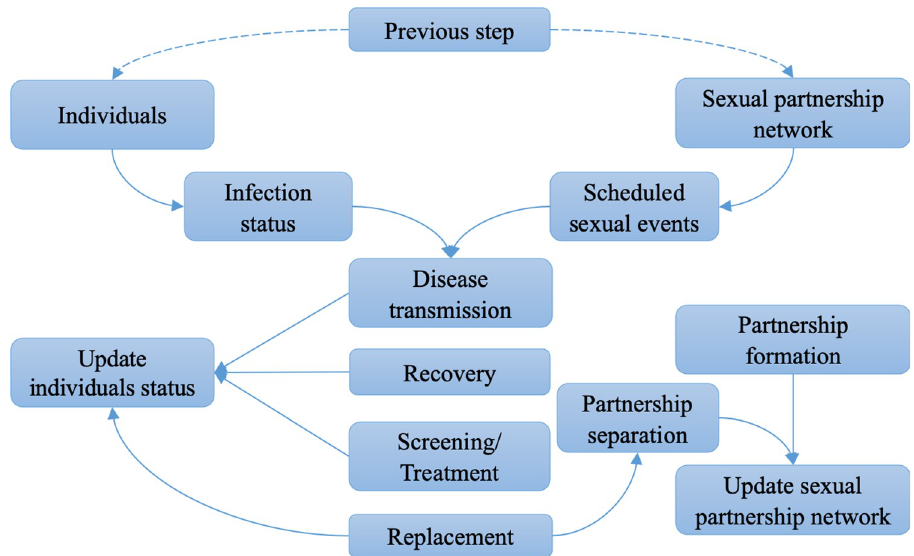
Fig 1. Schematic illustration of sequence of events that occur in a single daily simulation cycle of the individual- based model. In each cycle, the status of each individual and the sexual partnership network are carried over from the previous simulation step. Sexual events are scheduled daily for each partnership, and if disease transmission occurs, infection status is changed for the relevant individual(s). Events relating to natural progression of infection (“Disease transmission” and “Recovery”), testing, treatment of infection (“Screening/Treatment”) and entry/exit of individuals (“Replacement”) from the sexually active population are then processed before concluding each simulation cycle with partnership formation and dissolution for the next simulation cycle.